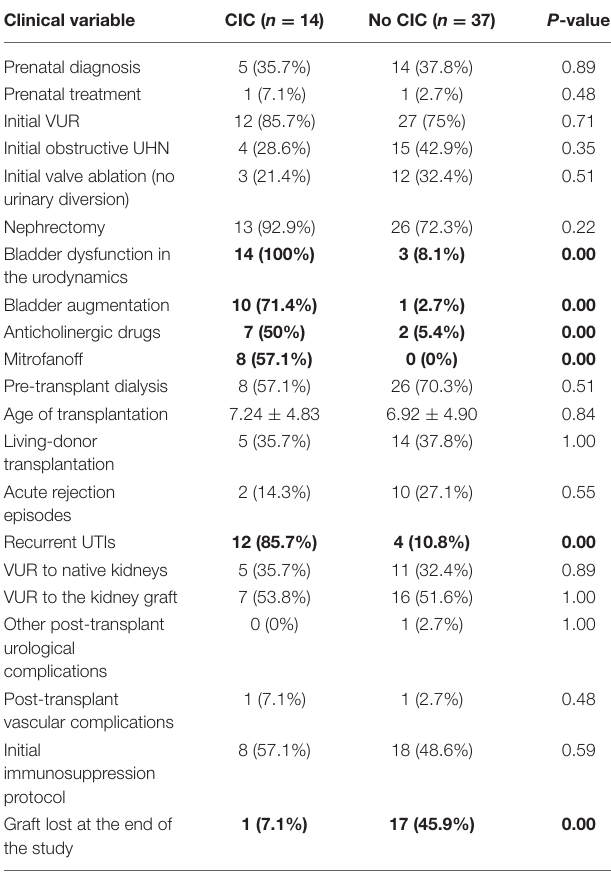
TABLE 1 | Comparative analysis of clinical characteristics in patients with CIC and without CIC. Clinical